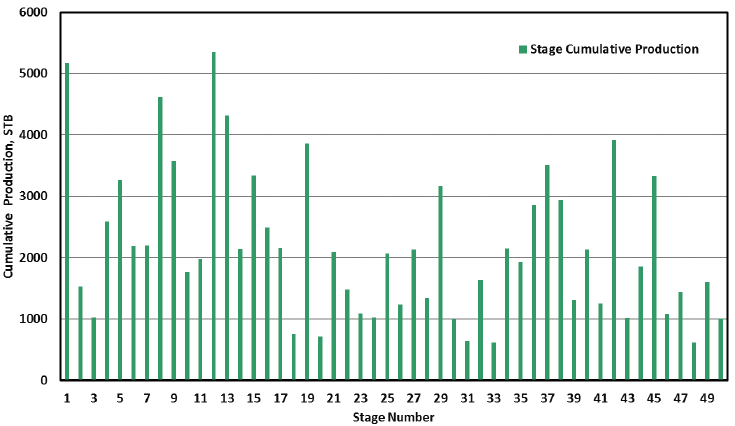
Figure 15. Same as Figure 14, with a focus on the 60–120 days of production. Energies 2021 , 14 , x FOR PEER REVIEW